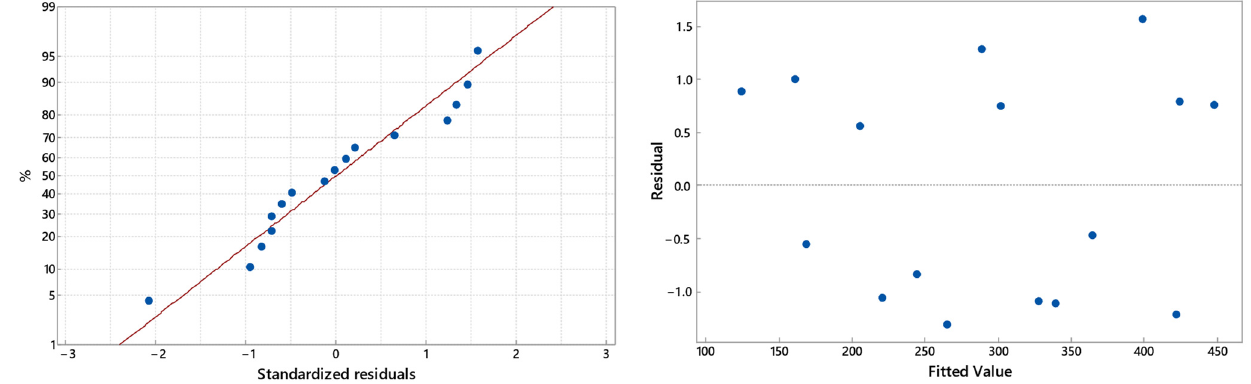
Figure 15. Left : Normal probability plot of standardized residuals. Right : Plot of standardized re- Figure 15. ( Left ): Normal probability plot of standardized residuals. ( Right ): Plot of standardized siduals vs. fitted values. residuals vs. fitted